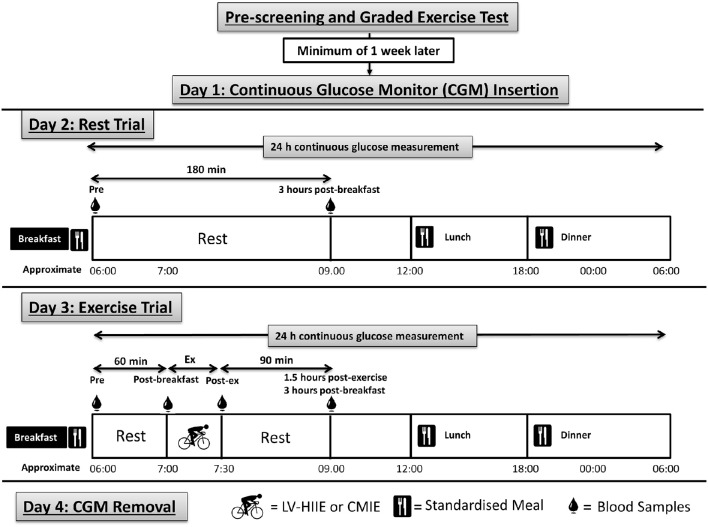
Detailed schematic of the research methodology and procedures. Participants were pre-screened and randomized into either LV-HIIE or CMIE exercise groups. Participants than underwent 4 consecutive days of testing. Day 1 consisted of CGM insertion and instruction of its appropriate use. Day 2 consisted of a rest non-exercise day. Day 3 was identical to day 2 with the addition of a single session of either LV-HIIE or CMIE performed 1 h after breakfast consumption. Day 4 consisted of removal of the CGM. Participants were provided a standard breakfast, lunch, dinner and snacks, to eat throughout the 4-day testing period. Meals were consumed at the same time of day over the testing period. Venous blood samples were taken at the time points indicated in the figure. CMIE, Continuous moderate-intensity exercise; LV-HIIE, low-volume high-intensity interval exercise; CGM, continuous glucose monitor.